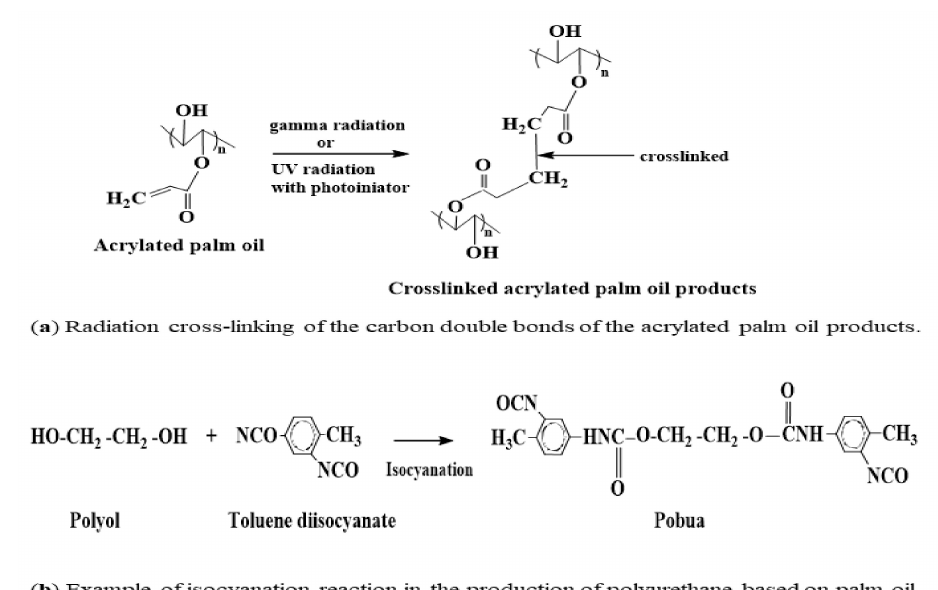
Figure 9. Application of acrylated palm oil and polyol in ( a ) radiation polymerisation of EPOLA ® or APO and ( b ) isocyanation of polyol in polyurethane production.